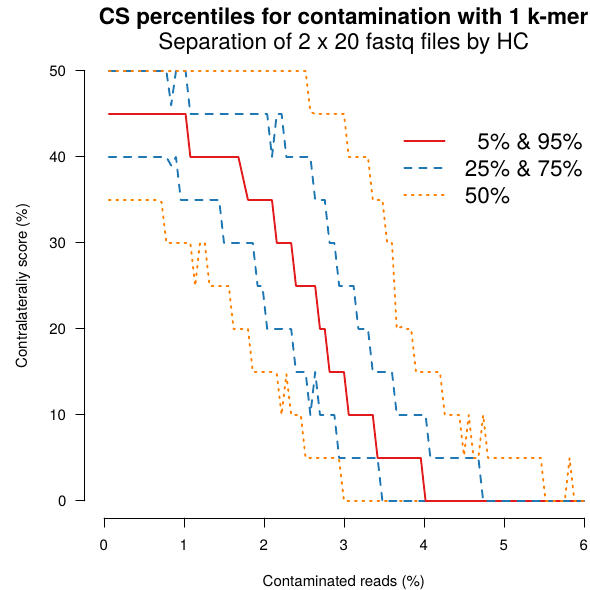
Figure 8. Separation sensitivity on simulated data: HcKmer was performed on Fastq files containing simulated DNA sequence ( k = 6). Percentiles for Contralaterality score (CS) are given for variable percentages of contamination with a single fixed DNA 6-mer. CS quantifies the presence of the minor present group in the first half of the HC-derived group labels. CS values <10% are considered to be statistically significant ( p <